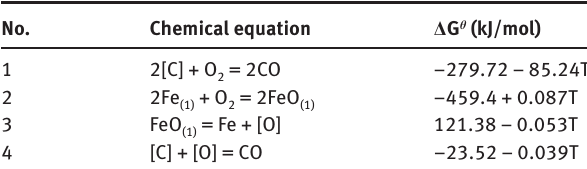
Table 1: Chemical equations and Gibbs free energies in decarburation